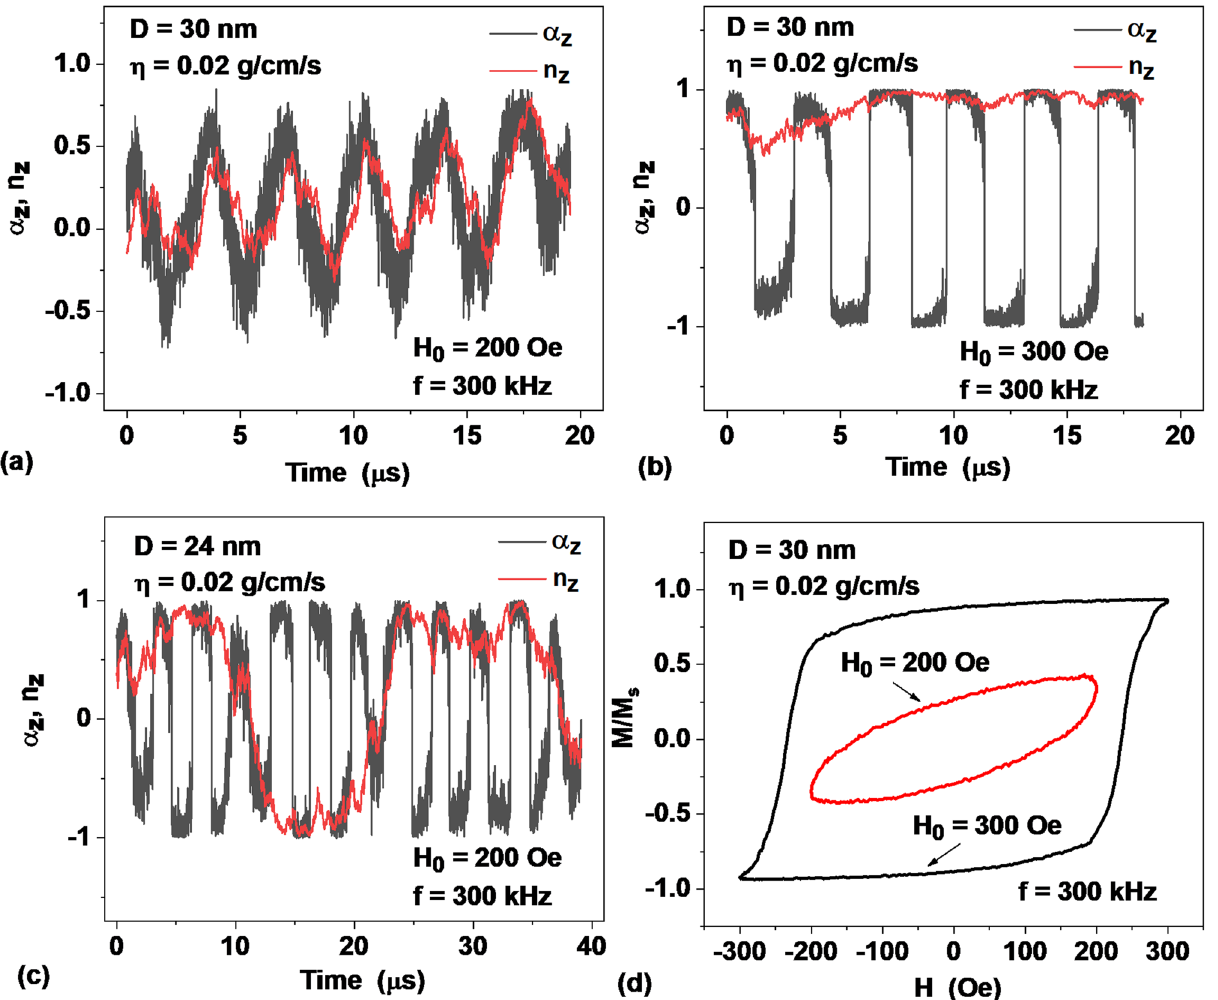
Figure 2. The nature of the motion of the unit magnetization vector and director of an individual nanoparticle of the assembly in a viscous liquid for different cases: ( a ) developed viscous mode, point 1 in Fig. 1a, ( b ) developed magnetic mode, point 2 in Fig. 1a, ( c ) intermediate regime, point 3 in Fig. 1a, ( d ) low frequency hysteresis loops for viscous and magnetic modes at points 1 and 2 in Fig. 1a,